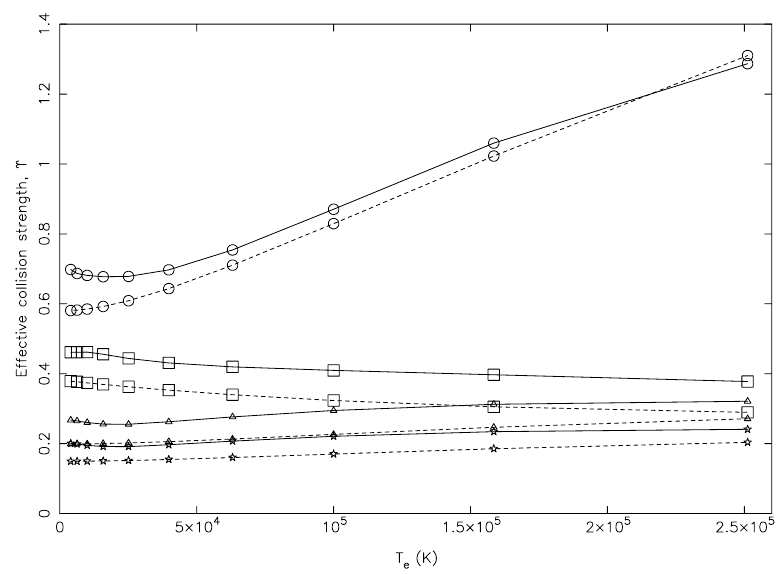
Figure 12. Comparison of effective collision strengths for the 1–6 (squares: 1s 2 S 1/2 –3s 2 S 1/2 ), 2–5 (circles: 2s 2 S 1/2 –3p 2 P o ), 2–15 (stars: 2s 2 S 1/2 –4f 2 F o 1/2